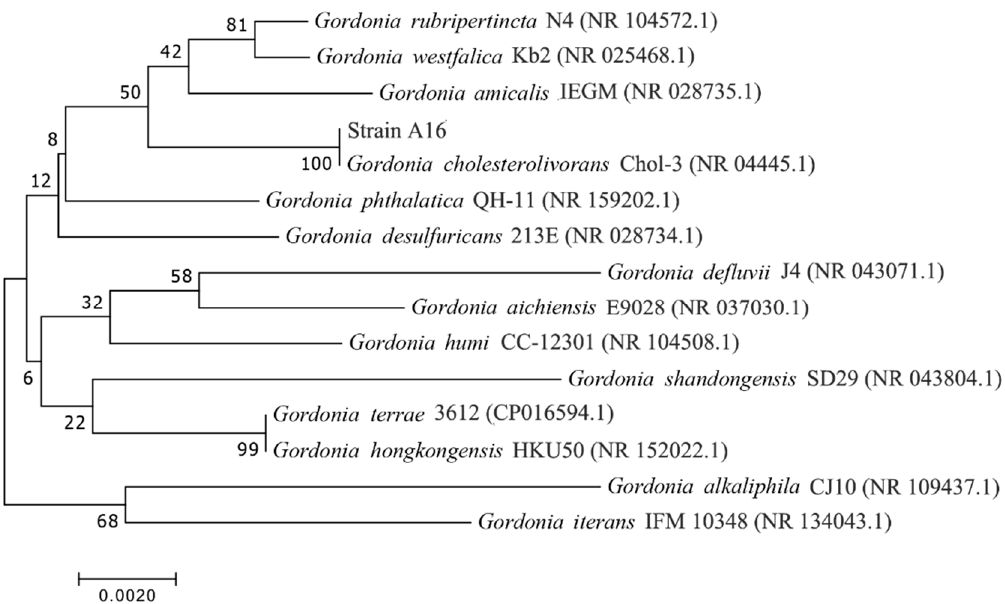
Figure 1. Phylogenetic analysis based on 16S rRNA sequence of strain A16 and similar bacterial strains. The phylogenetic tree was constructed using the neighbor-joining (NJ) method. Numbers in parentheses represent the GenBank accession numbers of the sequences.